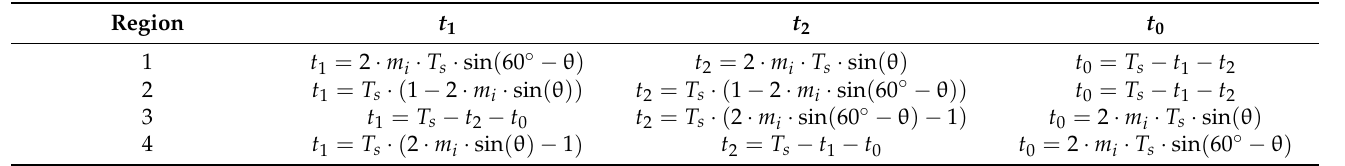
Table 4. Time calculation for different